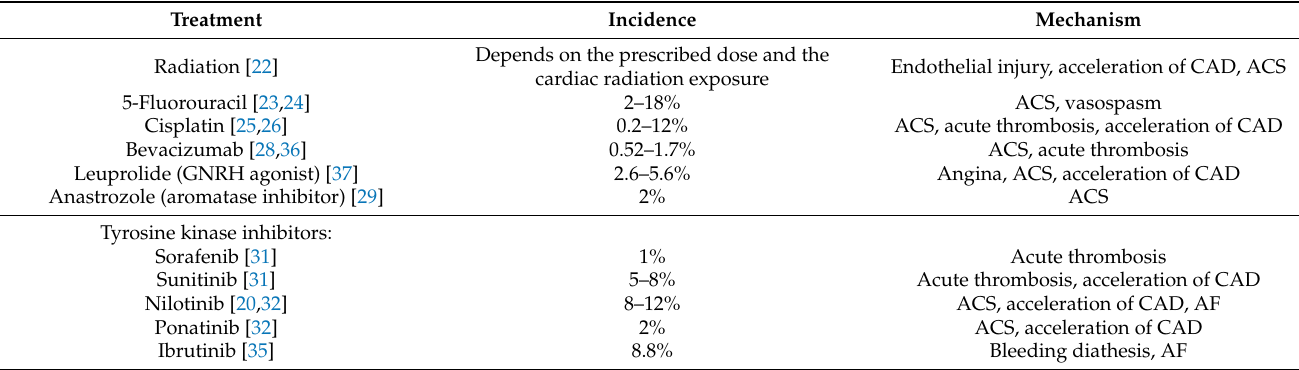
Table 1. Agents associated with cardiovascular